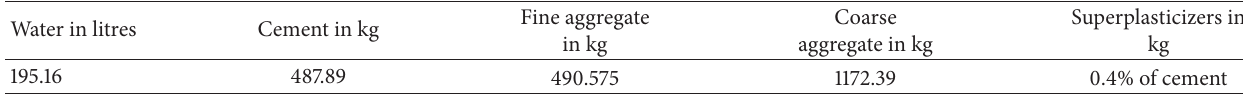
Table 3: Mix proportion for conventional concrete.